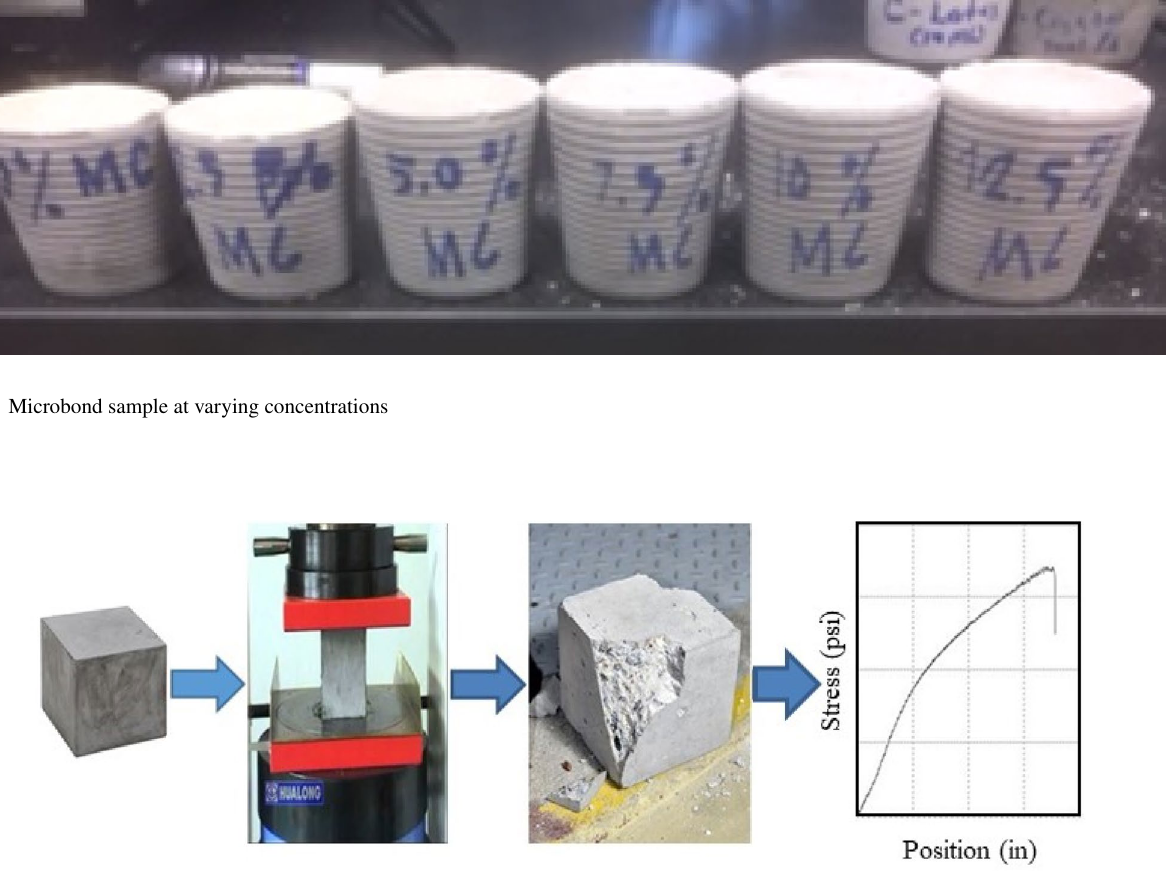
Fig. 11 Breakload/crush sample test and evaluation